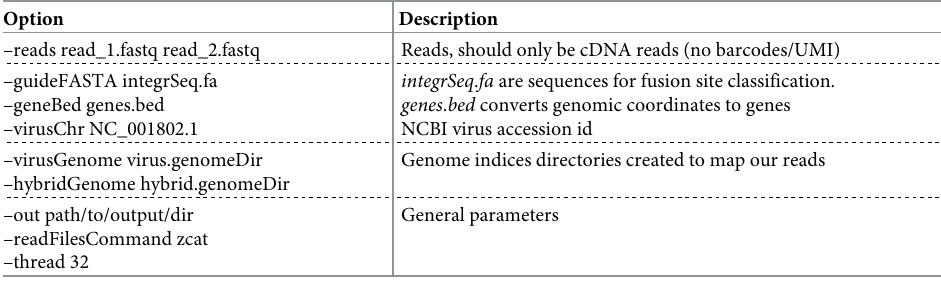
Table 2. Venus’s integration site discovery module parameters.